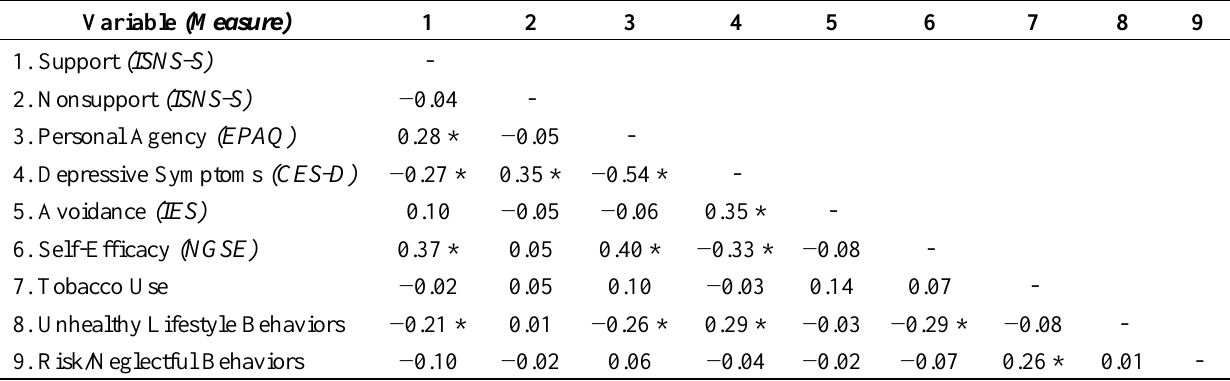
Table 3. Correlations among study